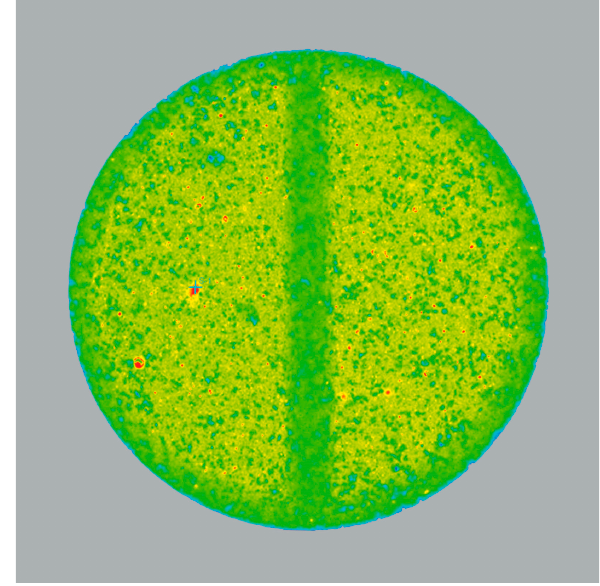
Figure 9. Raman correlation map showing the spatial distribution of loperamide hydrochloride; red sites are those with the highest, and blue sites are those with the lowest correlation of the Raman spectrum with that of loperamide hydrochloride.